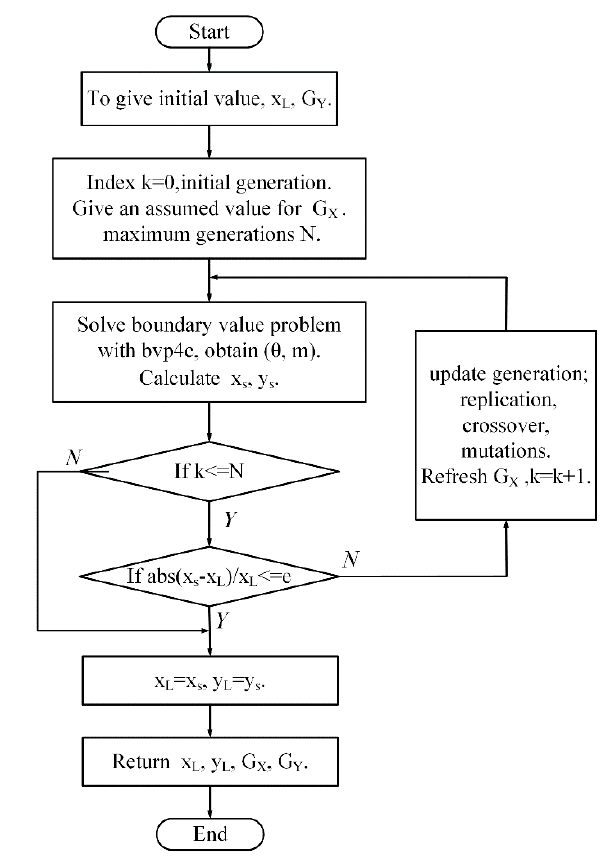
Figure 1. The model of the geometric anti-spring isolator. ( a ) Schematic of the geometric anti-spring isolator. ( b ) Photograph of the geometric anti-spring isolator. ( c ) Cross-section diagrams of the geometric anti-spring isolator. ( d ) The shape of the cantilever blade spring. ( e ) One dimension mechanical model of the blade spring.